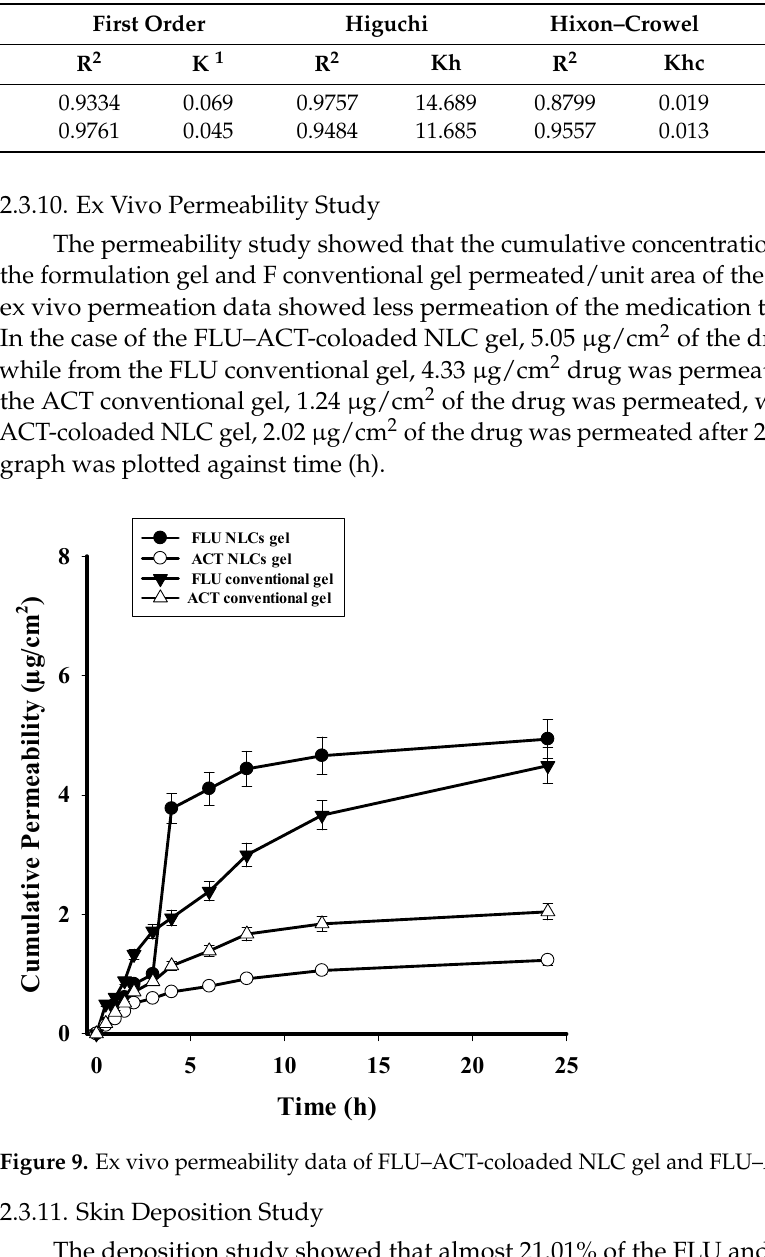
Table 3. Drug release kinetic models of optimized FLU–ACT-coloaded NLCs.